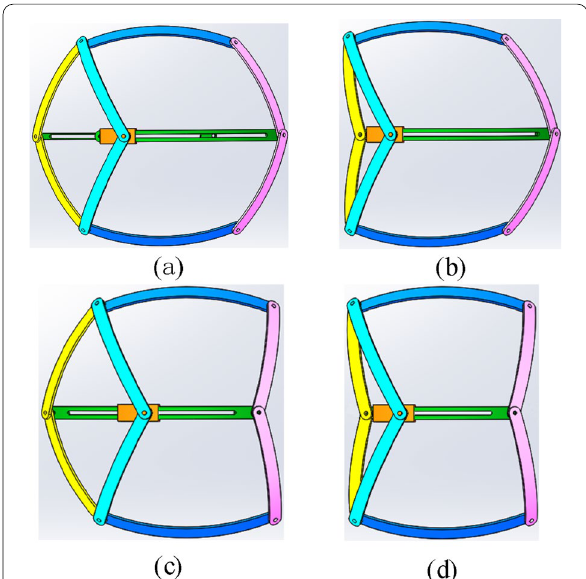
Figure 5 Four initial configurations with different arrangements of the drive